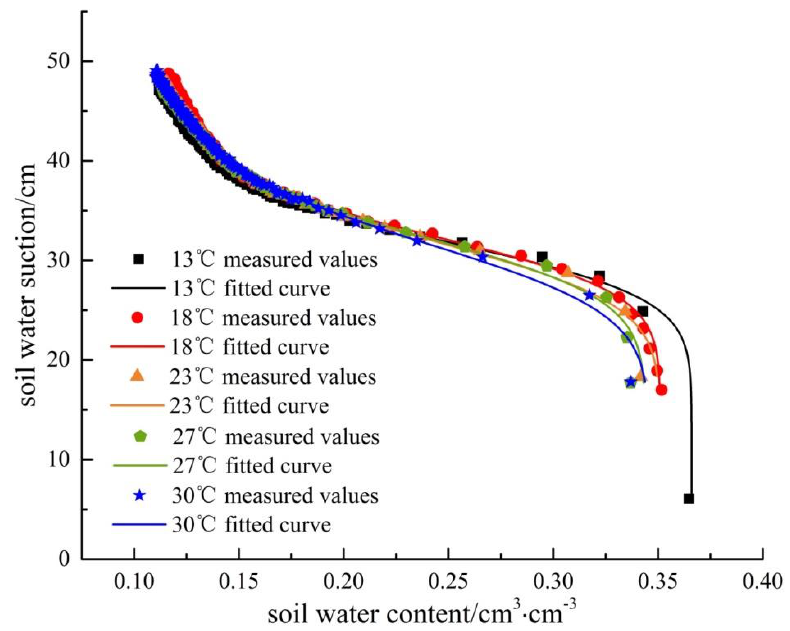
Figure 5. Measured data points and fitting curves from the soil column experiment.